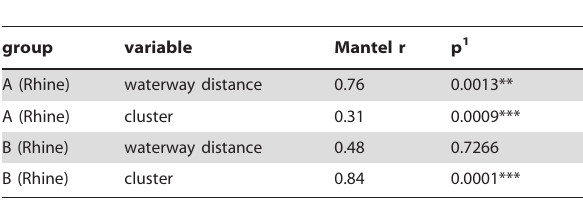
Table 2. Results of partial Mantel test, investigating the effect of clusters (A1.1, other A1, A2 for type A; B1, B2 for type B) on genetic differentiation when correcting for geographical